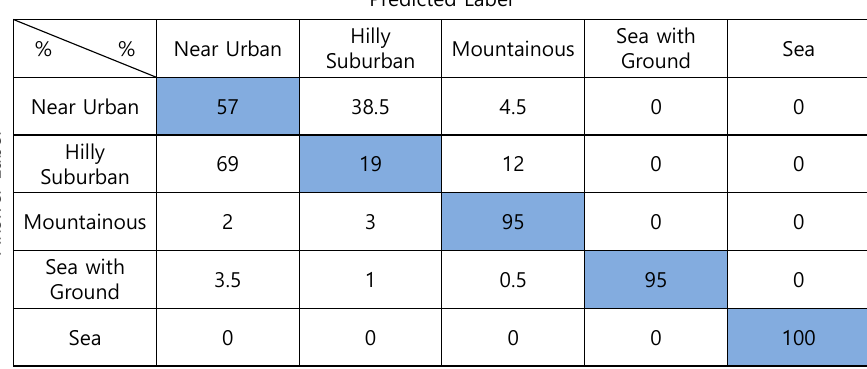
Figure 10. Confusion matrix of the correlation-based classification in [22].